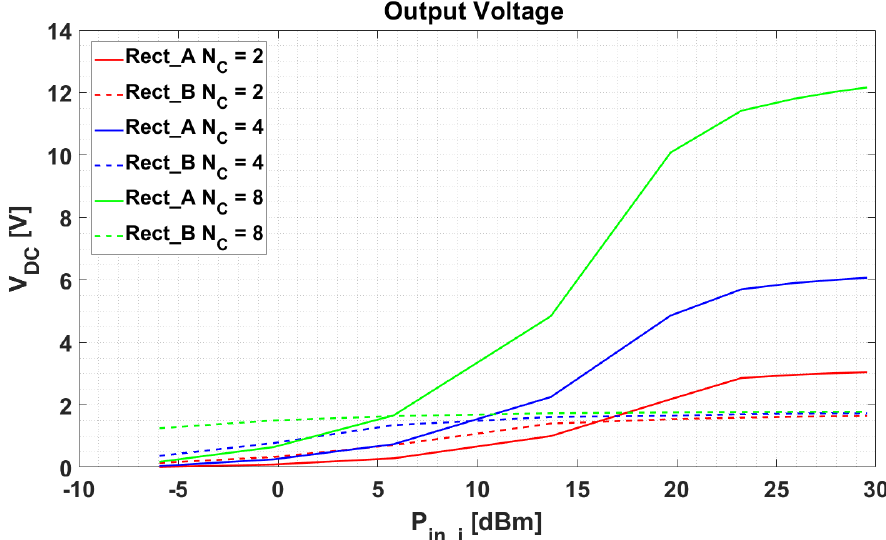
Figure 5. Output voltage delivered to the load as a function of the input power level P in ß of the carrier generator and the number of carriers N c ; simulation of both Rect _ A and Rect _ B systems are shown.